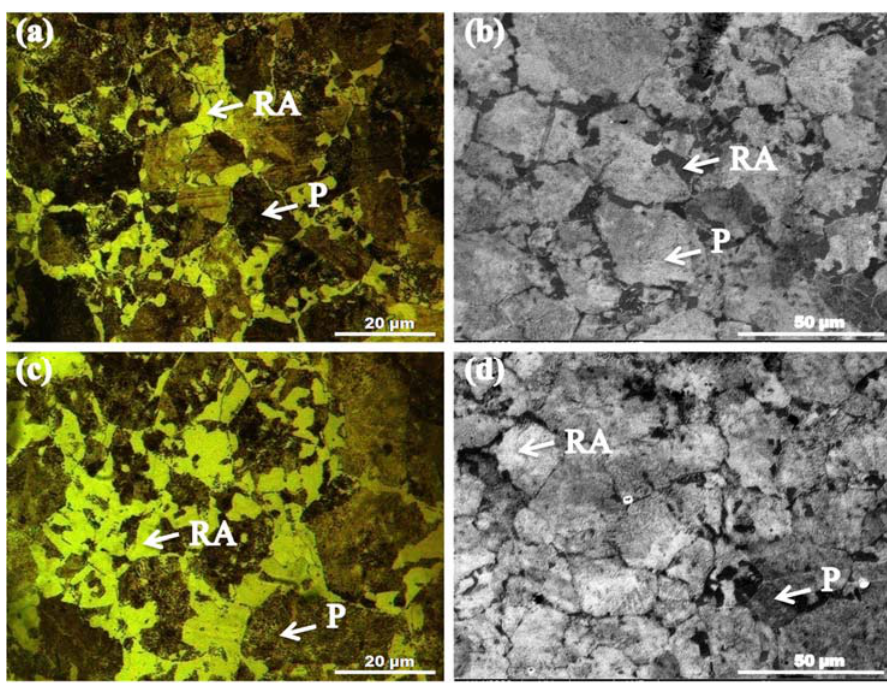
Figure 2. Microstructure of non-treated; ( a ) optical micrograph, ( b ) SEM micrograph, and TMSA treated; ( c ) optical micrograph, and ( d ) SEM micrograph AISI 1345 steel, containing pearlite (P) and retained austenite (RA) phases.